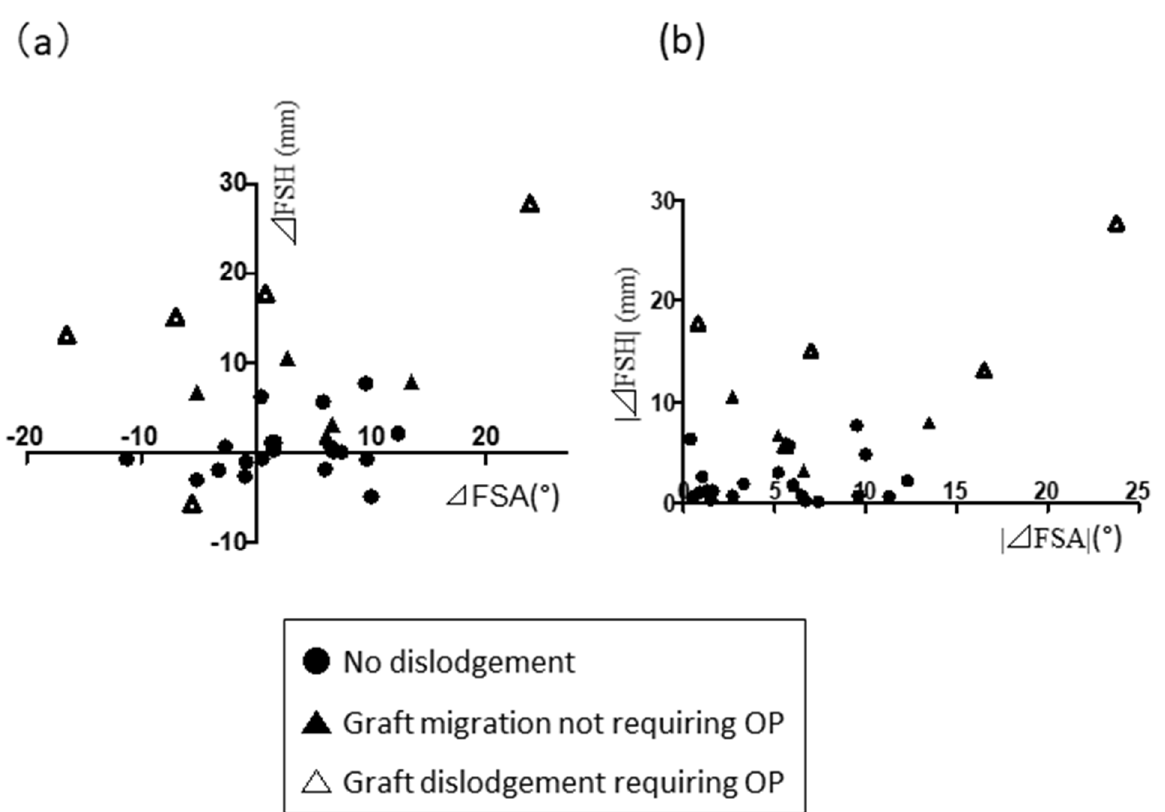
Figure 3. ( a ) Plot showing changes in FSA and FSH ( Δ FSA and Δ FSH) and the incidence of graft subsidence; ( b ) Plot showing associations between absolute values of Δ FSA and Δ FSH and graft migration. A large | Δ FSH| is more closely linked with graft migration than | Δ FSA|.